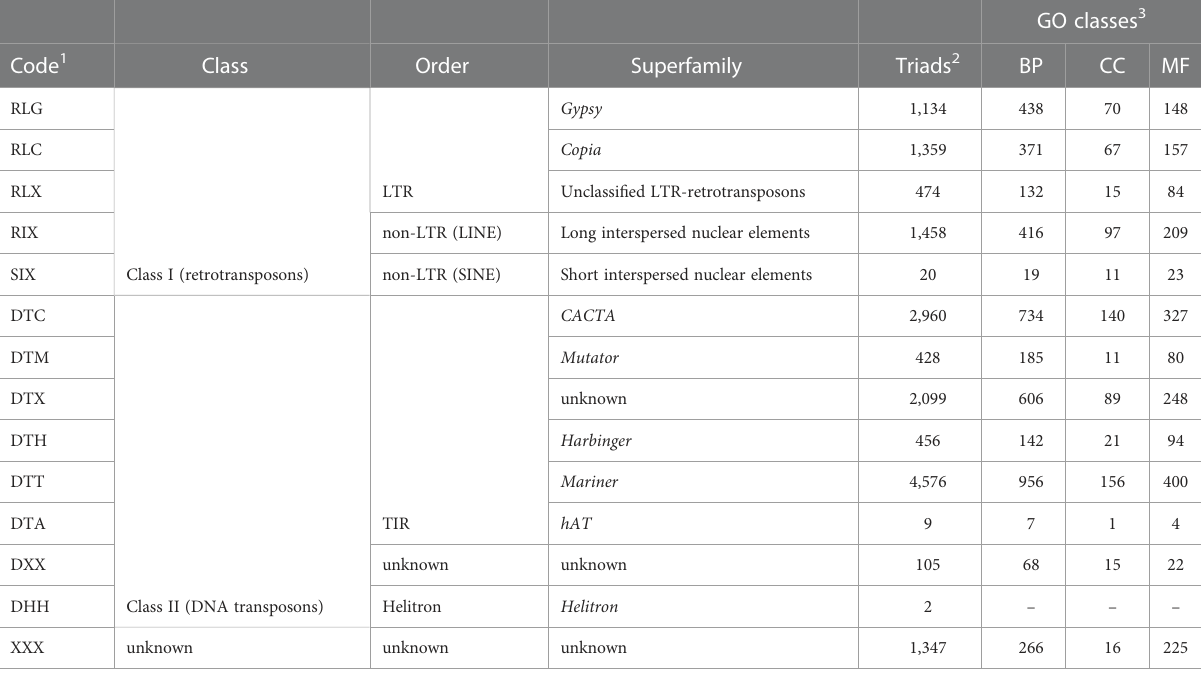
1 The three letters code represents the class ( fi rst letter), order (second letter) and superfamily (third letter) of the TE (Wicker et al., 2007). 2 Number of triads in which at least one of the genes includes TE insertion from the speci fi c superfamily. Note that the sum of the triad column is larger than 7,439. This is since some triads include insertions from more than one subfamily. 3 Numberofsigni fi